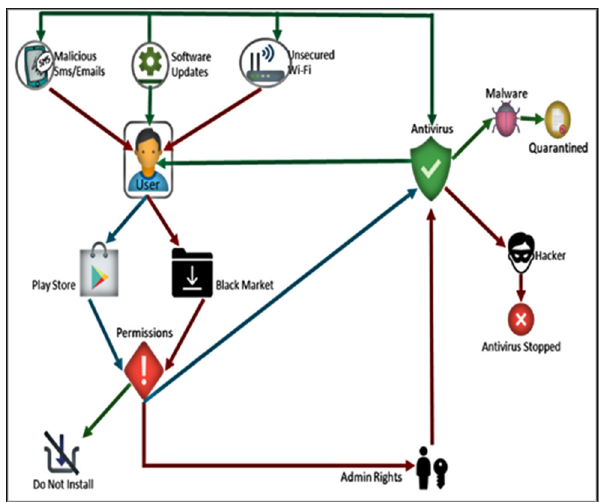
Fig. 11: Graphical illustration of defined prevention